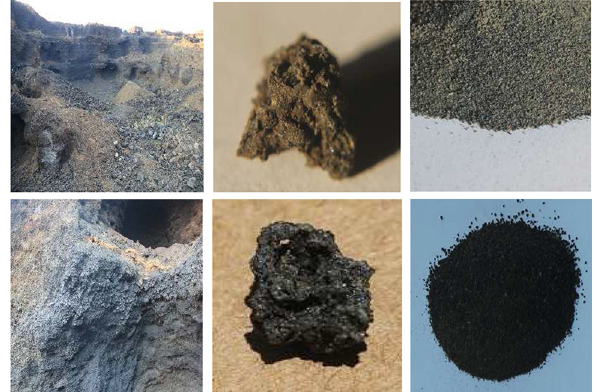
Fig. 3 Scoria samples.